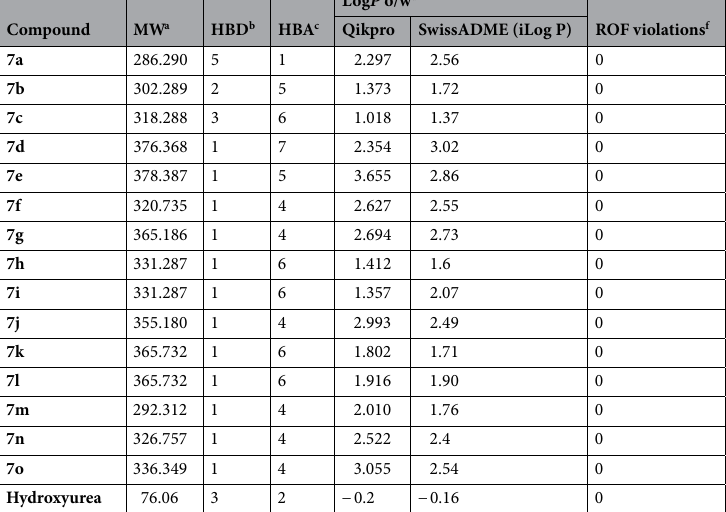
Table 3. The calculated physico-chemical property of the synthesized compounds 7a–o for predicting drug-likeness based on Lipinski-rule of five. a Molecular weights (acceptable value ≤ 500). b Number of average Hydrogen Bond Donor (acceptable value ≤ 5). c Number of average Hydrogen Bond Acceptor (acceptable value ≤ 10). d Predicted octanol/water partition co-efficient (acceptable value ≤ 5). e Number of violations of Lipinski’s rule of five (maximum